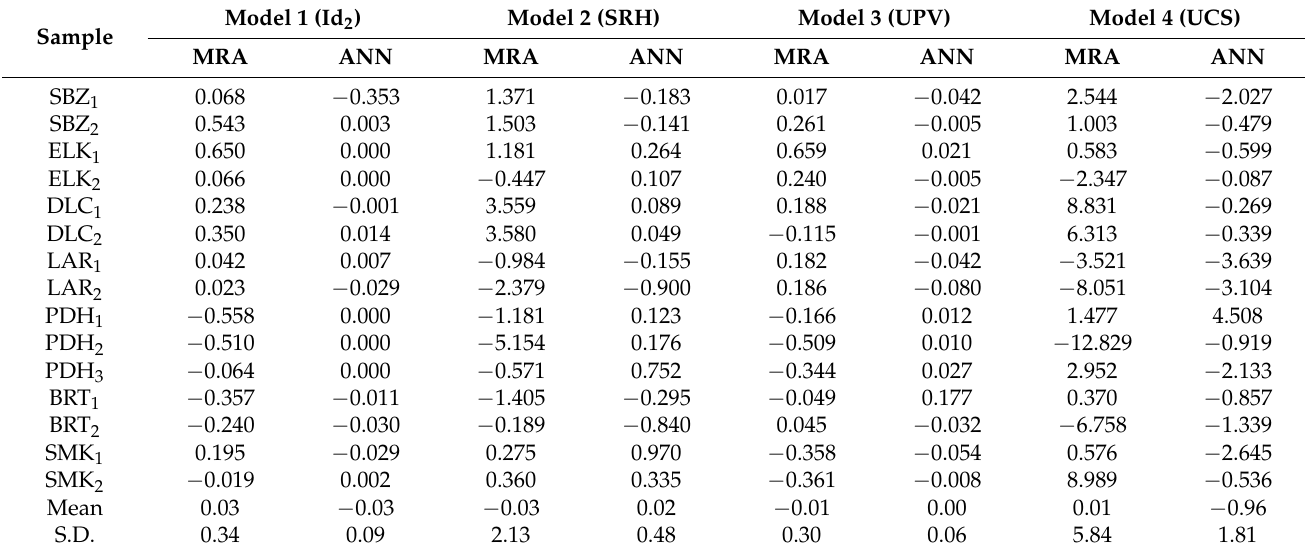
Table 12. Residual error values of MR and ANN